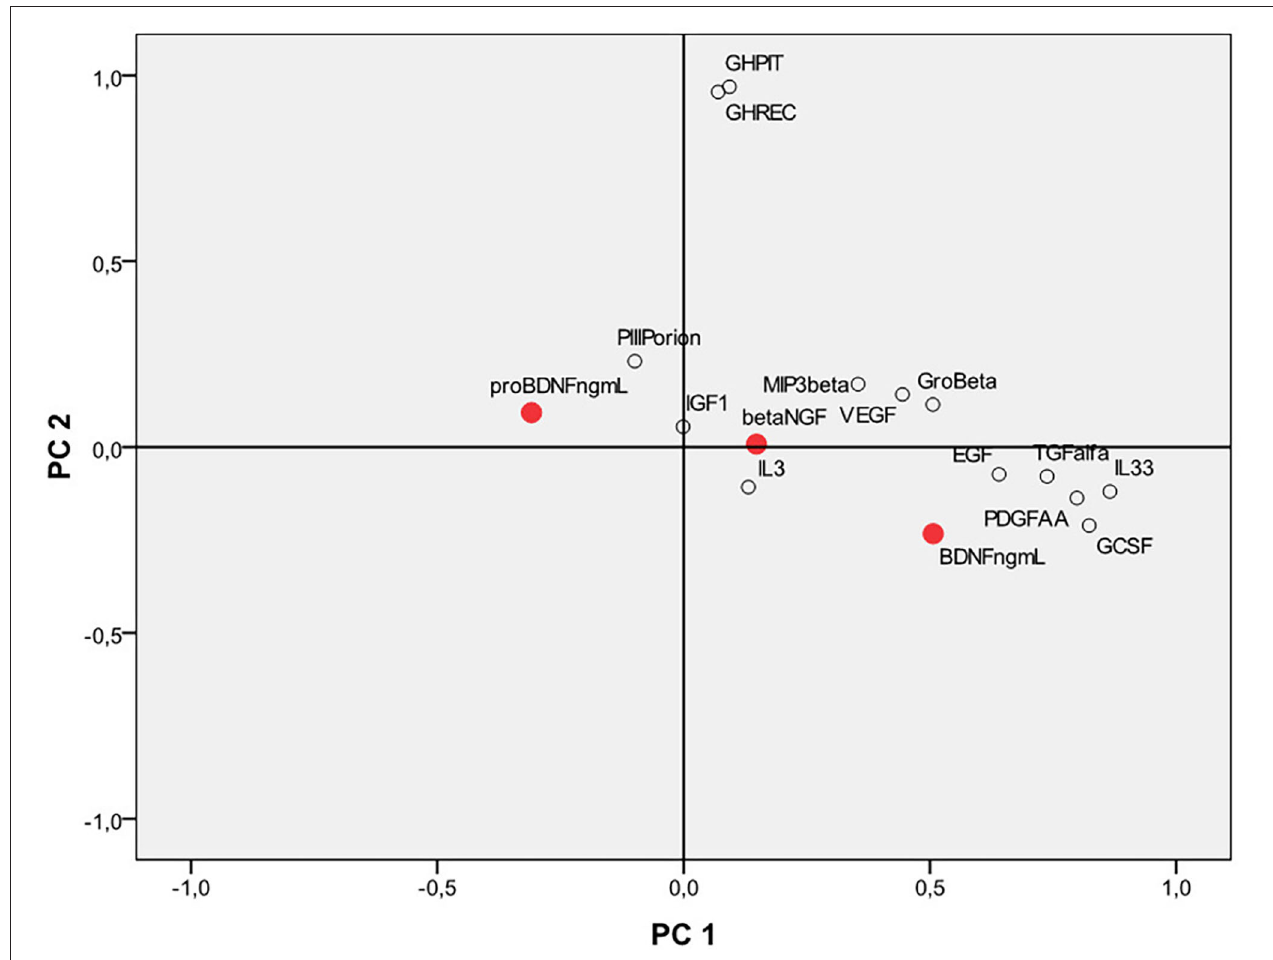
FIGURE 4 | Principal component analysis (PCA) considering the neurotrophins BDNF, proBDNF, beta NGF and other growth factors, and human inflammation markers. BDNF, brain derived neurotrophic factor; proBDNF, pro-brain derived neurotrophic factor; beta-NGF, beta-nerve growth factor.